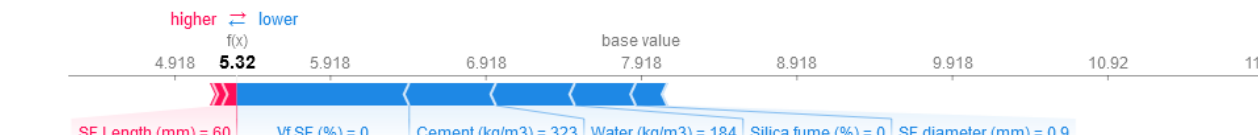
Figure 22. Flexural strength feature importance.